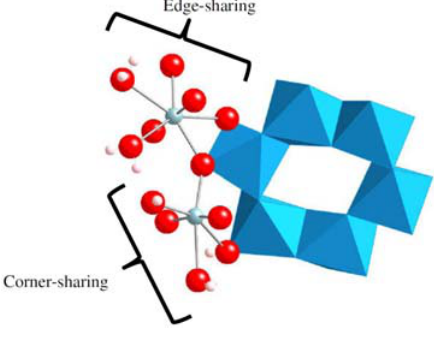
Figure 18. The optimized structure of the corner- and the edge-sharing configuration of uranyl adsorption complexes on gibbsite